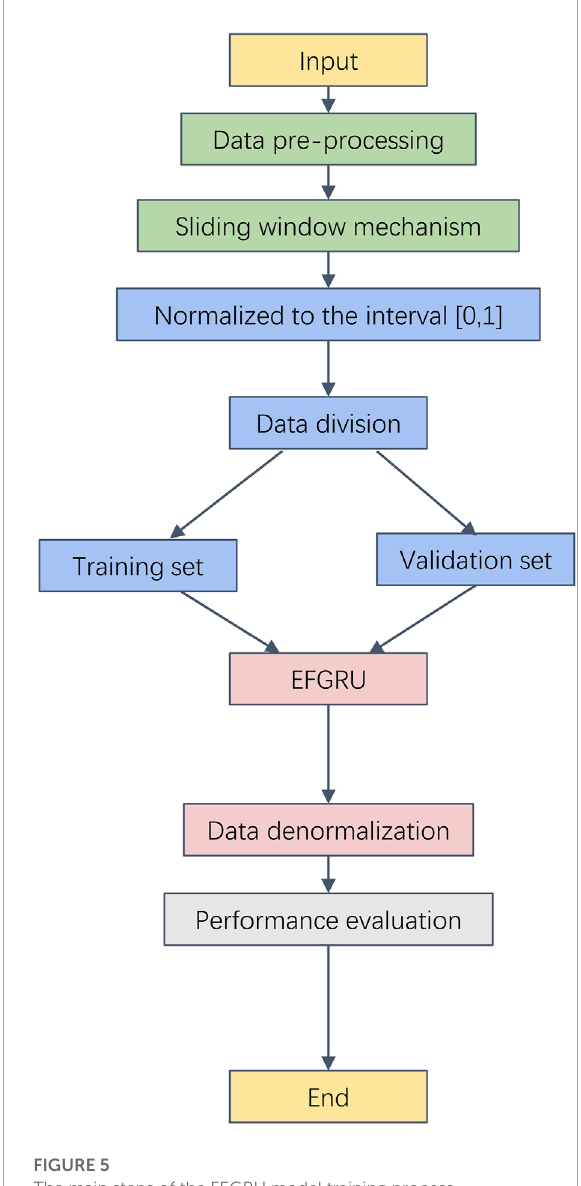
FIGURE 5 The main steps of the FEGRU model training process.